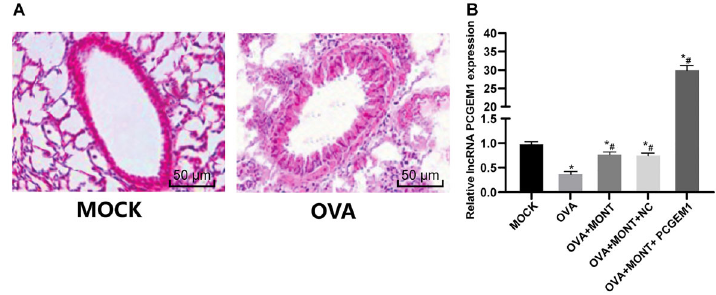
Figure 2. Prostate cancer gene expression marker 1 (PCGEM1) was expressed at a low level in ovalbumin (OVA)-sensitized asthmatic mice and normal control (MOCK). A , In fi ltration of in fl ammatory cells in the lung tissues of asthmatic and control mice detected by HE staining (n=3, scale bar: 50 m m); B . RT-qPCR determination of lncRNA PCGEM1 expression in lung tissues of untreated asthmatic mice (n=3) and after treatment with montelukast sodium (MONT) and PCGEM1. Data are reported as means ± SD. *P o 0.05 vs the MOCK group; # P o 0.05 vs the OVA group (one-way ANOVA, followed by Tukey ’ s multiple comparisons post hoc test). NC: negative